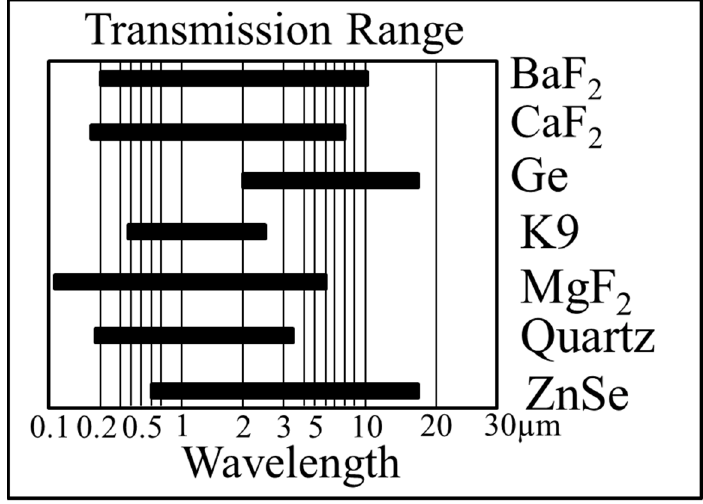
Figure 2. Comparison of transmission ranges for different window materials.